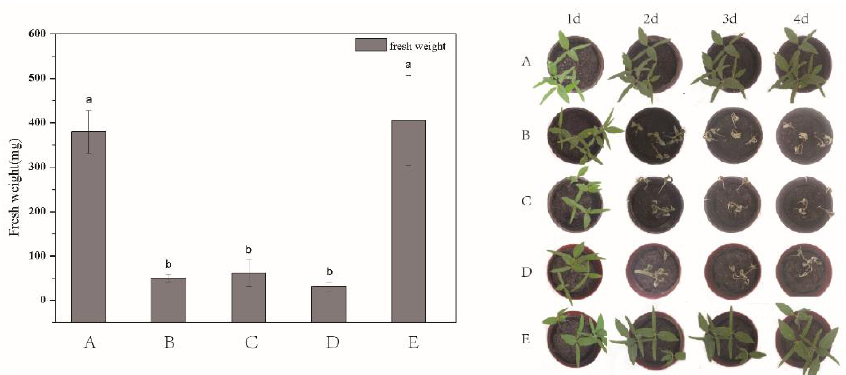
Figure 8. Herbicidal activity for target plant datura ( Datura stramonium L.) determined in terms of fresh weight: (A) water, (B) free DQ technical in water, (C) DQ@MSN-SO 3 in water, (D) DQ@MSN-SO 3 in 0.1M Na 2 SO 3 aqueous solution, and (E) 0.1M Na 2 SO 3 aqueous solution. Error bars correspond to standard errors of triplicate measurements. Bars marked with different letters are statistically different at p ≤ 0.05 as determined by Duncan’s multiple range test.